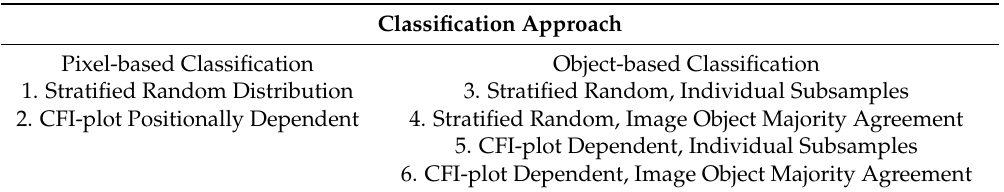
Table 1. Six total methods used for UAS reference data collection, between Pixel-based (PBC) and Object-based (OBC) classification